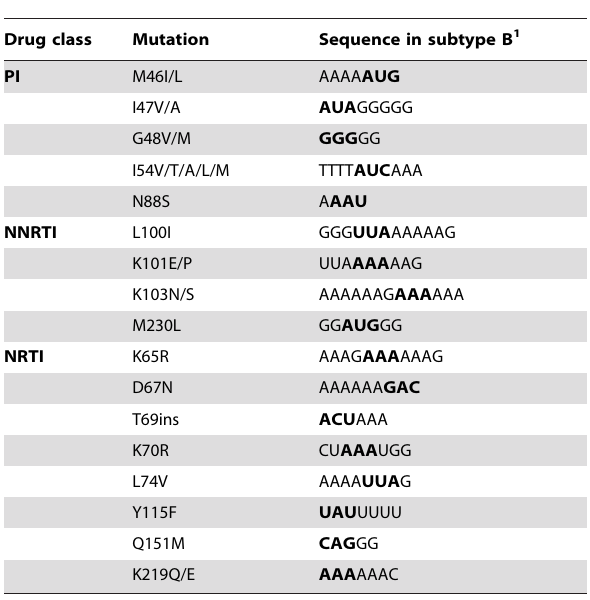
Table S1 Primer sequences for three amplicons spanning the HIV pol gene. Amplicon name (Pro, RT1, or RT2), primer name, MID tag, and primer sequence for 48 different forward and